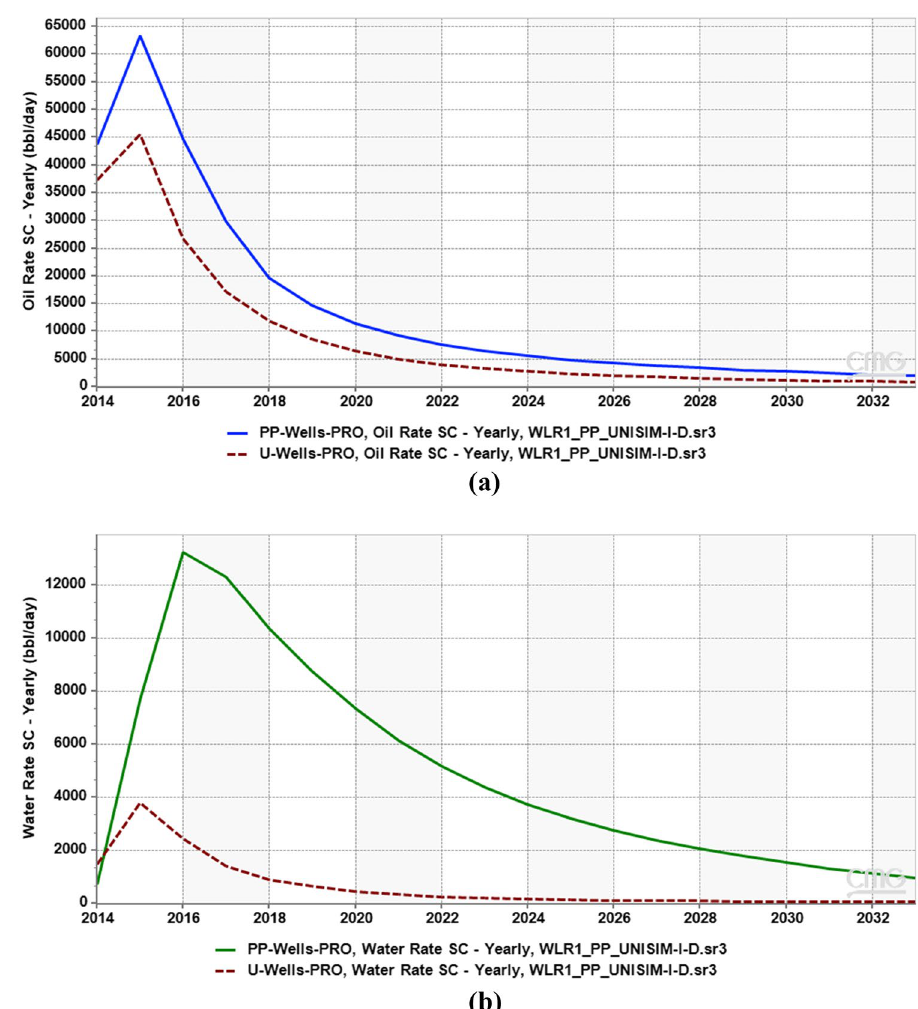
Fig. 11 OR-SC ( a ) and WR-SC ( b ) for grouped U-Wells and